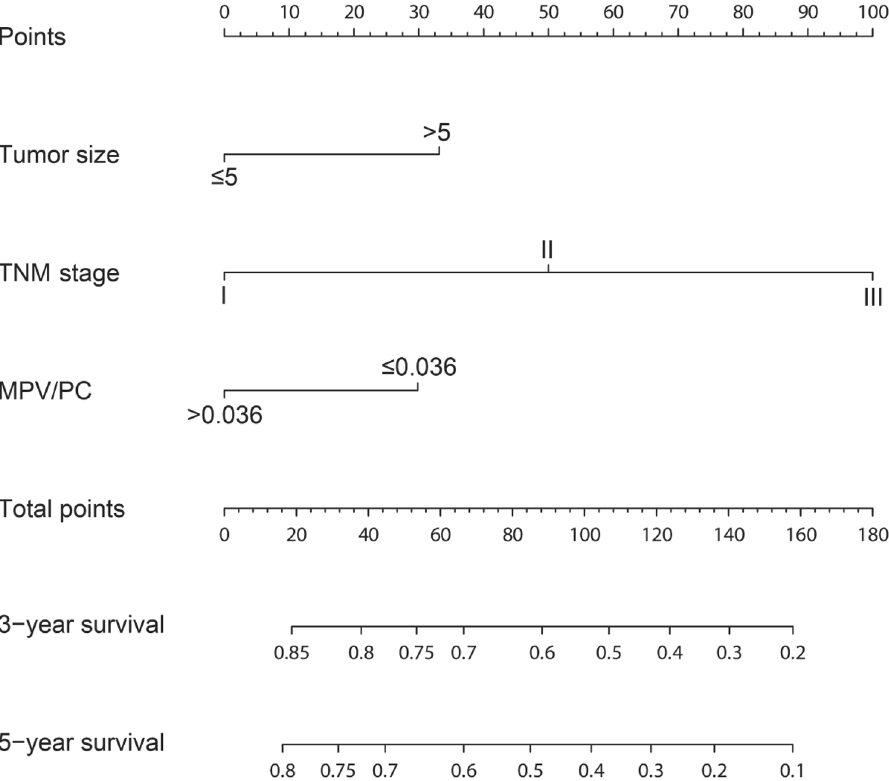
Figure 3. The nomogram integrating tumor size, MPV/PC and TNM stage for OS of patients with resectable gastric